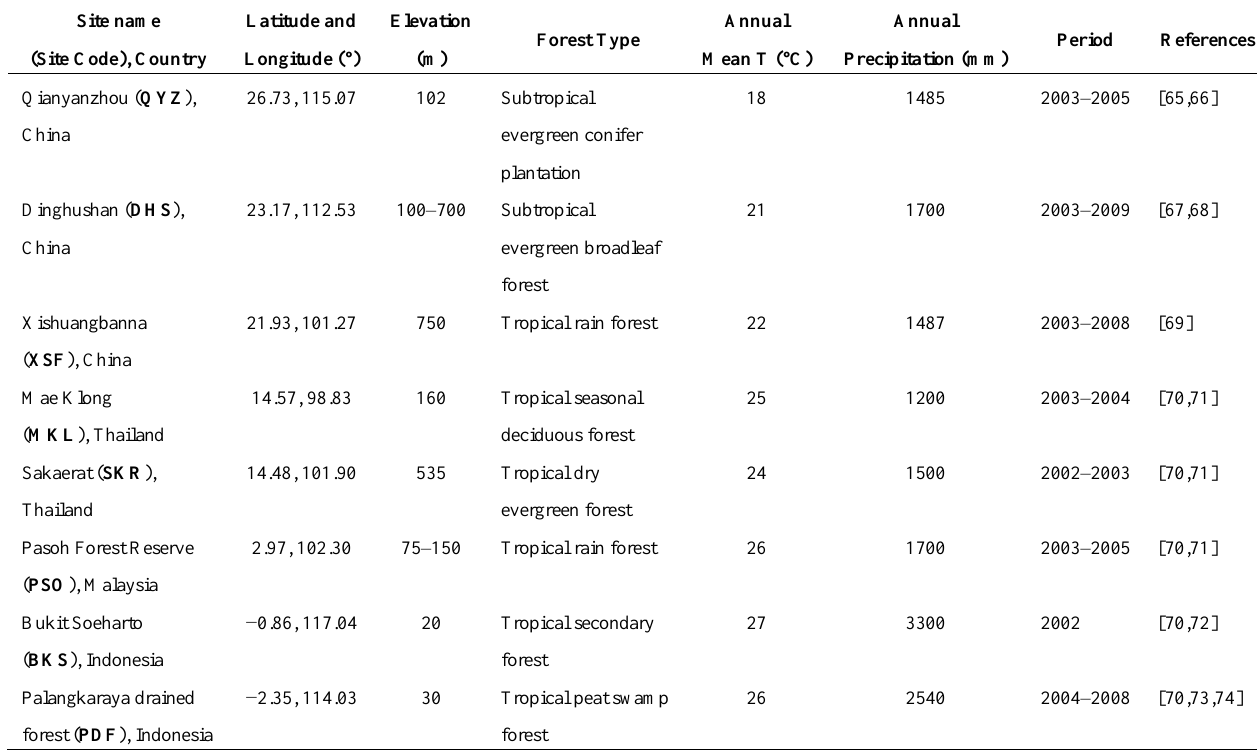
Table 1. Description of the eddy covariance towers used for the GPP validation. The daily GPP was available from the Qianyanzhou (QYZ) site in the ChinaFlux Network and the Palangkaraya (PDF) site in the AsiaFlux Network. Annual GPPs are from the references listed for the eight